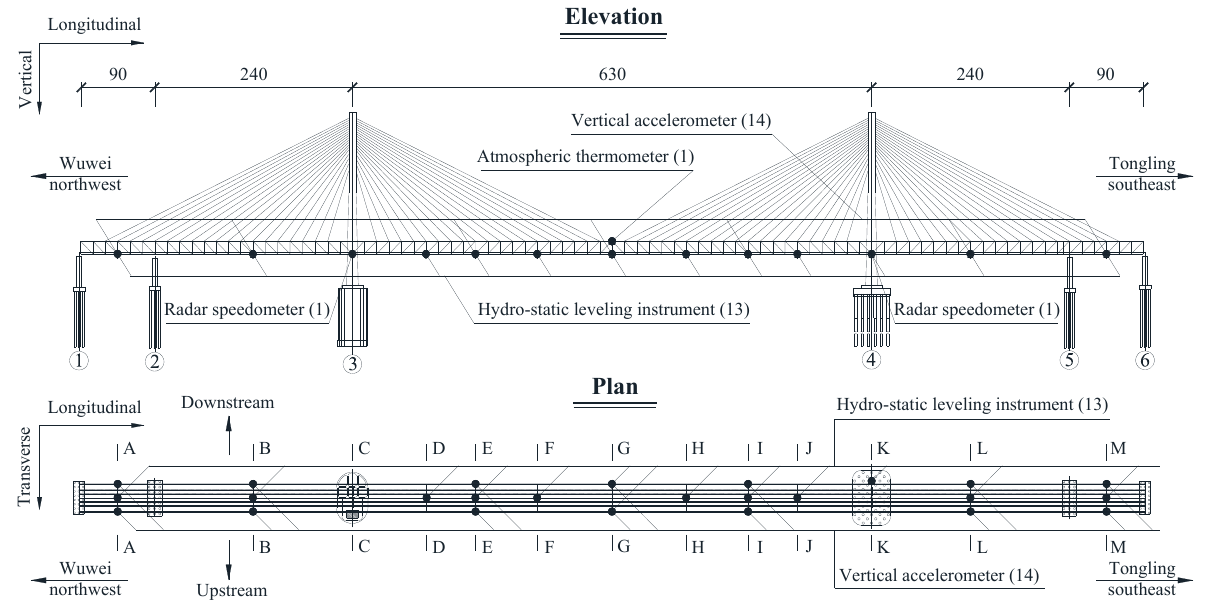
Figure 1. Deployment of monitoring sensors of the bridge (unit: meters).